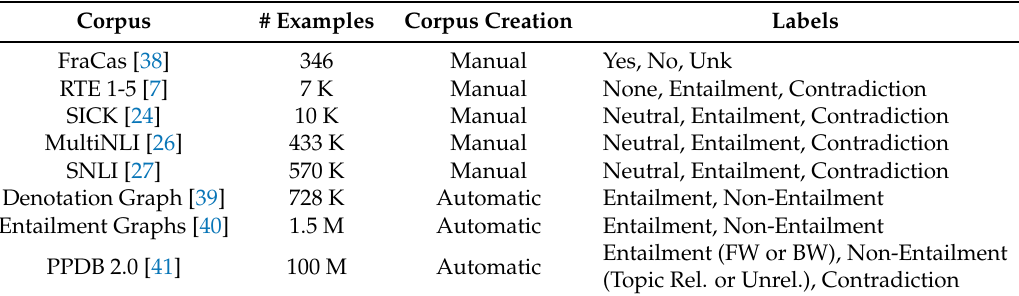
Table 1. Available corpora for recognizing entailment relations in English text (based on Bowman [37]). “# Examples” indicates the number of labeled sentence pairs in the corpus. “Corpus Creation” indicates whether the corpus contains pairs of natural language sentences that were manually added by human annotators (“Manual”) or automatically generated (“Automatic”). “Labels” indicates the different labels that were assigned to each